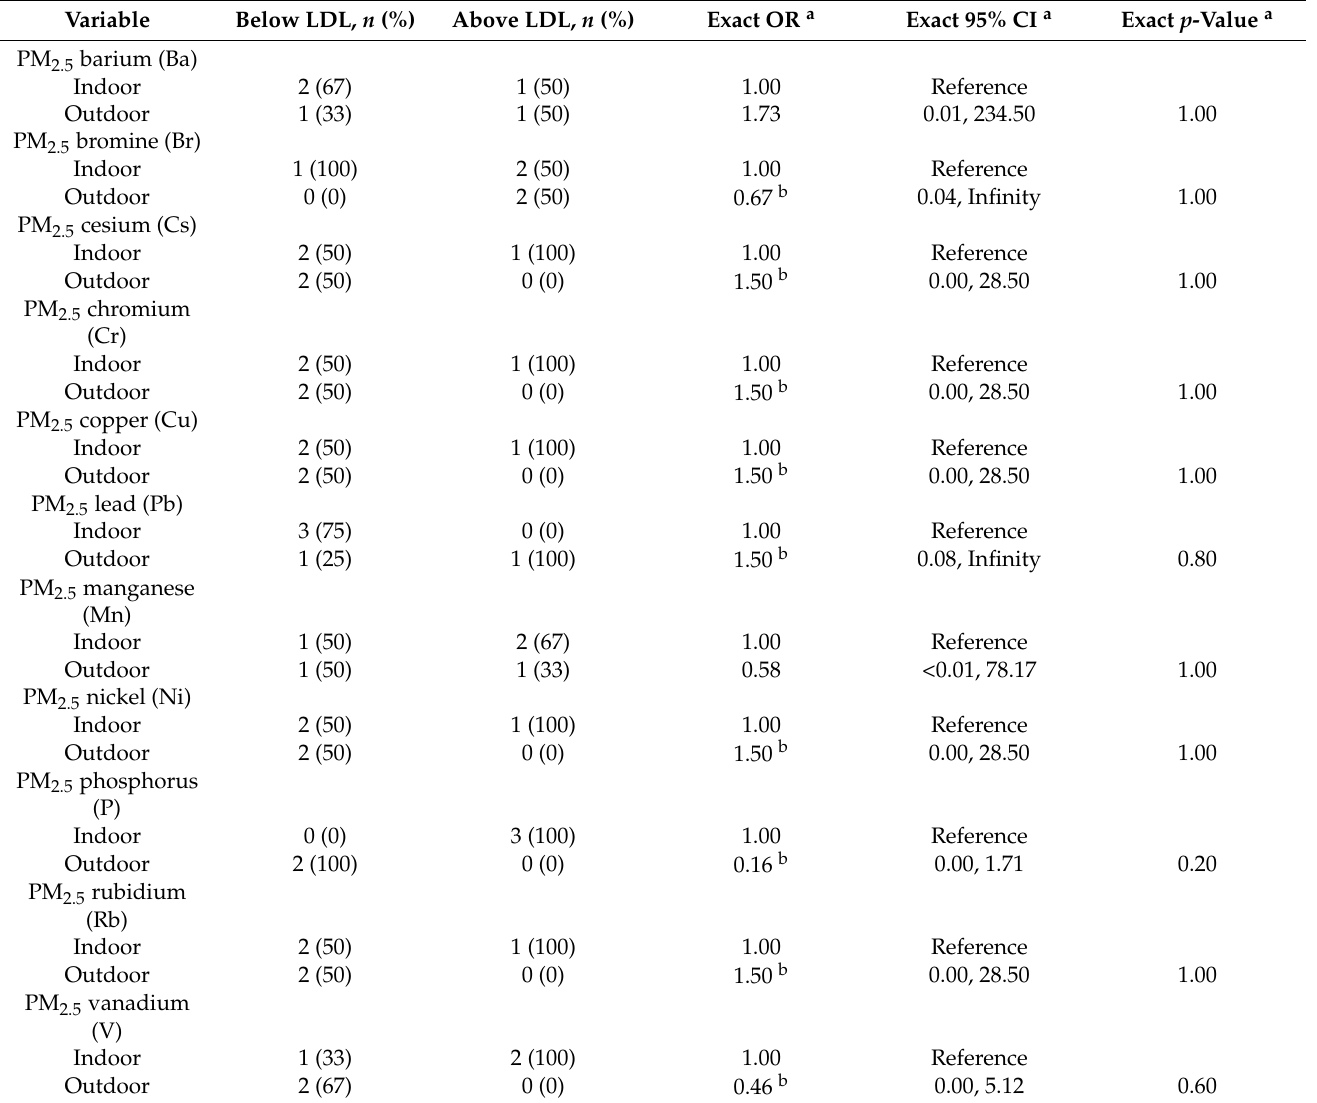
Table 3. Associations between having mean (of the sampling period) measurements above LDLs and location of samples from teahouses in villages along the Poon Hill circuit trek, Nepal, May